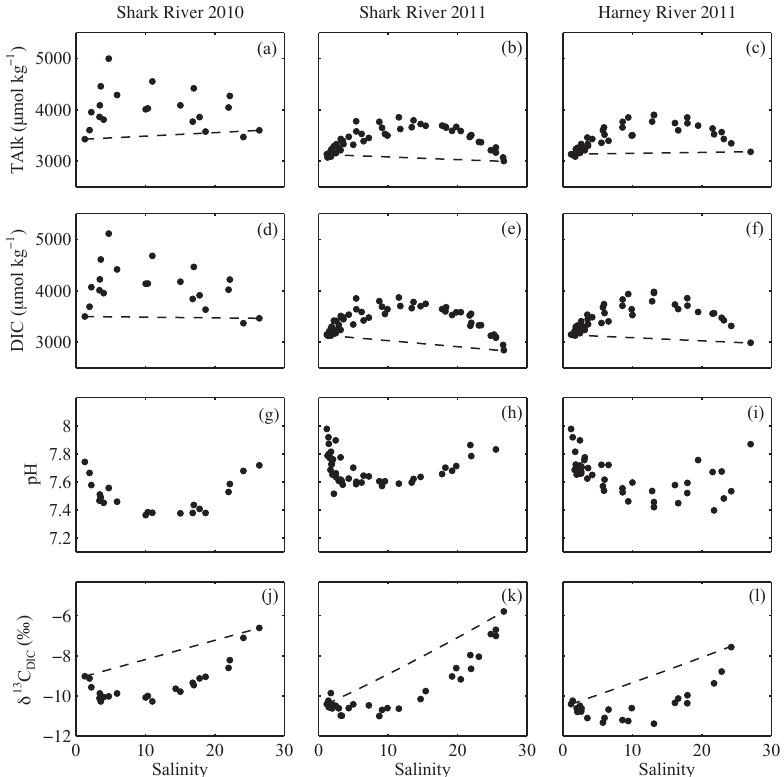
Figure 3. Distribution of TAlk (a–c) , DIC (d–f) , pH (g–i) , and δ 13 C DIC (j–l) along the salinity gradient in the Shark and Harney rivers during the 2010 (SharkTREx 1) and 2011(SharkTREx 2) campaigns. During SharkTREx 1, TAlk and pH were measured at FIU, and DIC was calculated using CO2SYS (Pierrot et al., 2006). During SharkTREx 2, DIC and TAlk were measured at NOAA/AOML, and pH was calculated using CO2SYS. The dashed lines indicate the distribution expected for conservative mixing.